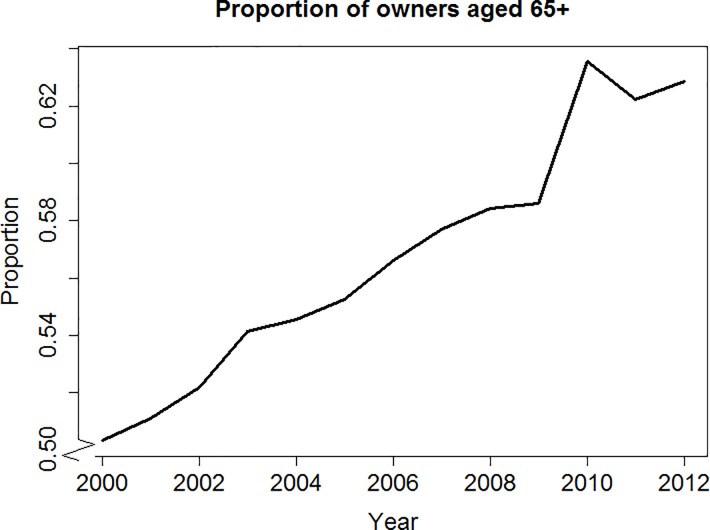
Proportion of Scottish cattle farms with owners aged 65 and more (2000–2012).